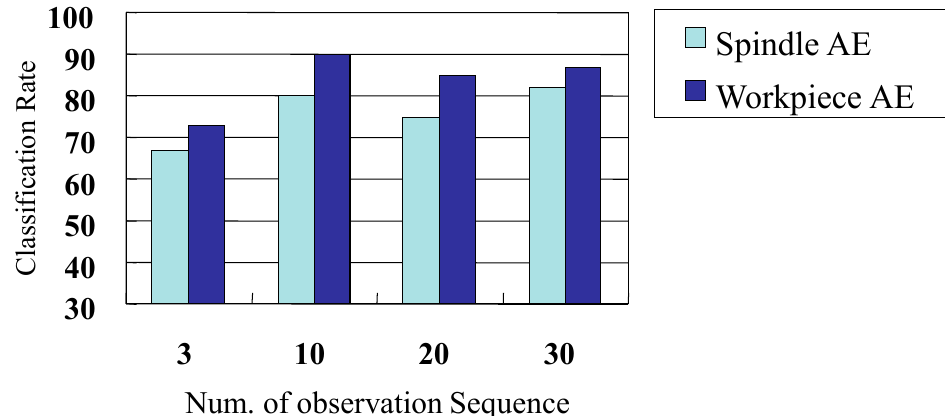
Figure 13. Effect of observation sequence on classification rate (64 KHz feature bandwidth).